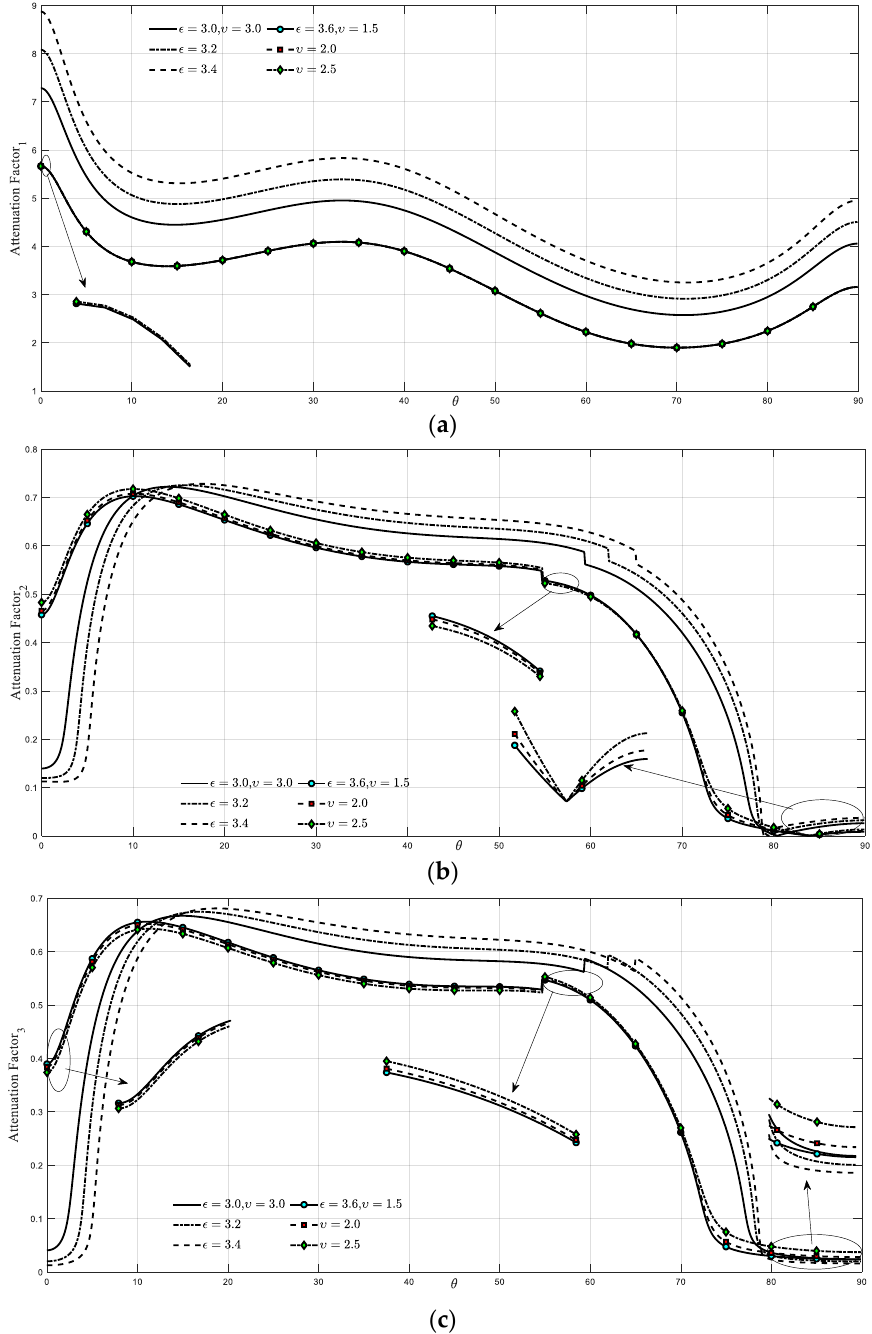
Figure 5. ( a ) Attenuation factor 1 for different angle of incidence; ( b ) Attenuation factor 2 for different angle of incidence; ( c ) Attenuation factor 3 for different angle of incidence.